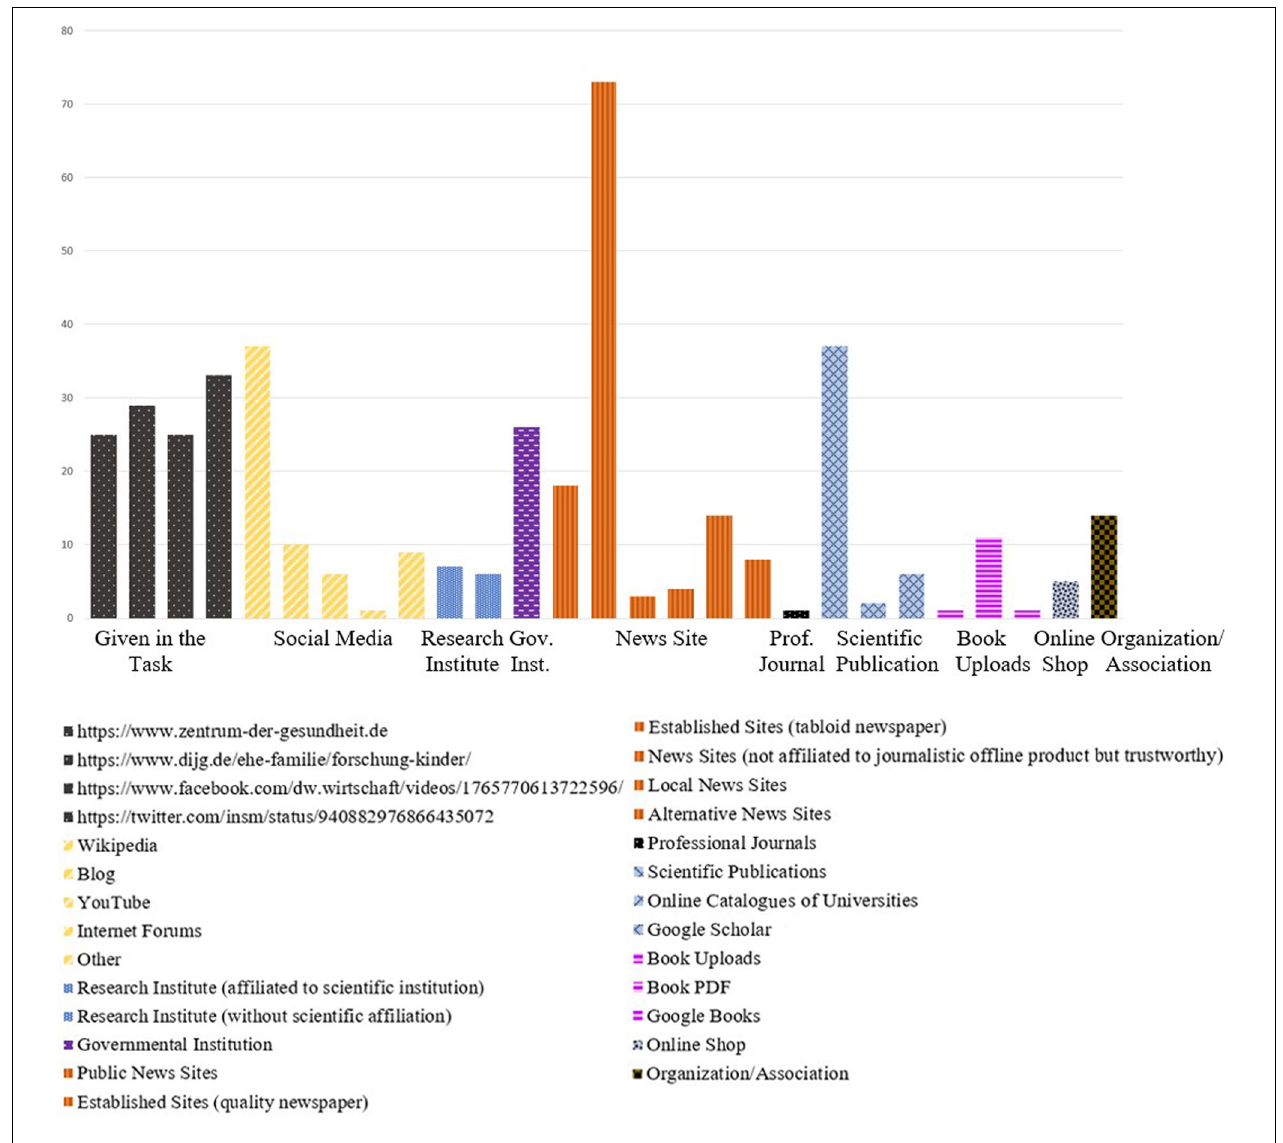
FIGURE 1 | Origin of the websites.